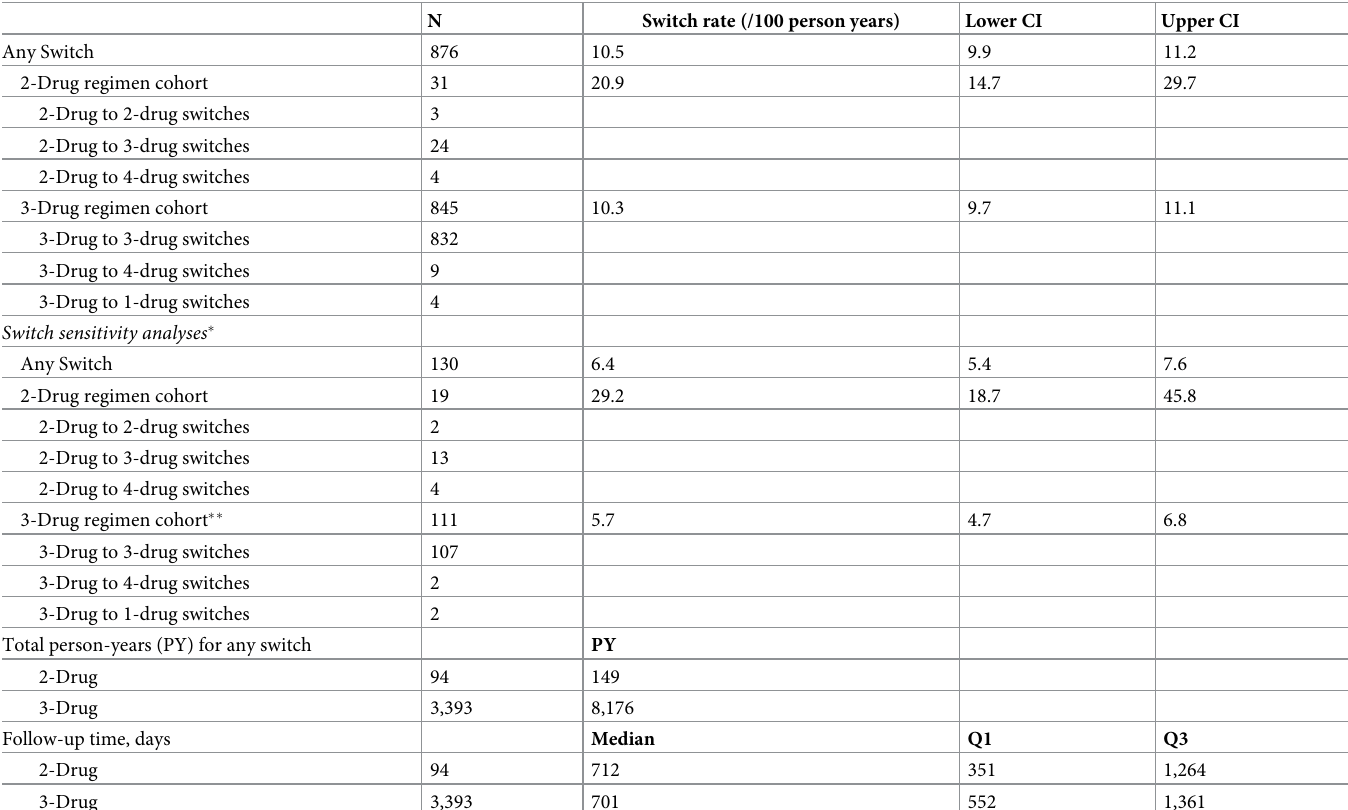
Table 2. Treatment switching patterns. N Switch rate (/100 person years) Lower CI Upper